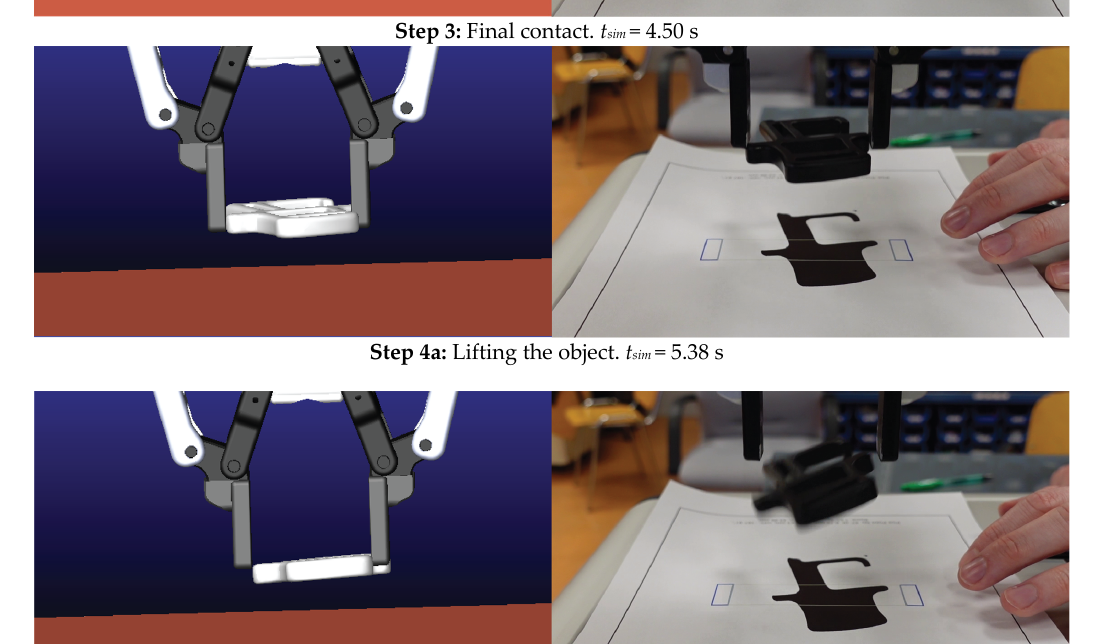
Figure 19. Contact forces between the left and right fingers and the object (red and blue line), and the contact force between the object and the ground (black line) for the third pick-point. The orange and blue circles indicate the events on Figure 18. The dashed line indicates the desired contact force. Source: own. As can be seen from Figure 17, the robotic gripper initiates the contact at around the t sim = 1.75 s and starts grasping the object at around t sim = 4.50 s. The contact force increases to around 15 N while establishing solid contact. Still, it drops to zero a fraction of a second later. Again, in the next attempt, the contact force increases toward 50 N, as the contact surface is different because the object rotated from its initial position. The object is suc- cessfully grasped between time t sim = 4.10 s and t sim = 4.50 s, yet not lifted, as indicated by the nonzero contact force between the object and the surface. At a time around t sim = 4.60 s, the contact force C o-g becomes zero since the object is lifted from the surface. At around t sim = 6.75 s, the object drops toward the ground due to the lack of proper friction force between the robotic gripper’s fingers and the object.